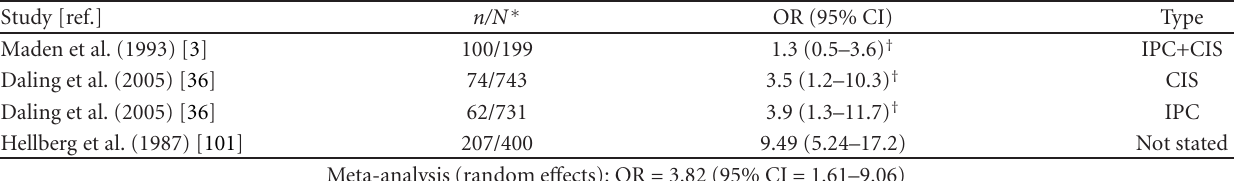
Table 4: Association between balanitis and penile